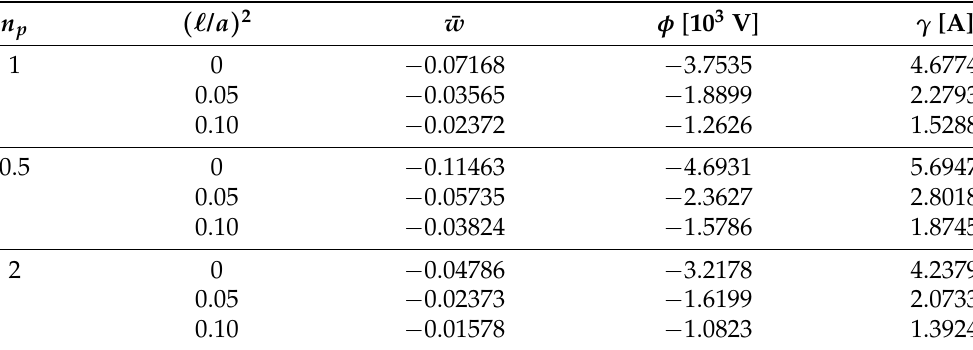
Table 4. Displacement ¯ w , electric and magnetic potential φ and γ , of a square nanoplate in central point ( a /2, b /2 ) for different values of nonlocal parameter ( (cid:96) / a ) 2 and n p . (SDL; q = 0 N/m 2 ,